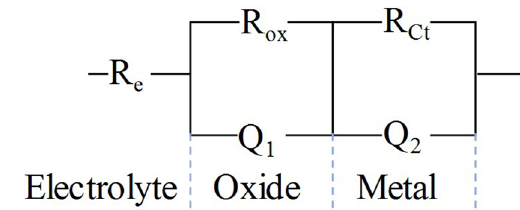
Figure 11 . Equivalent circuit used to adjust experimental